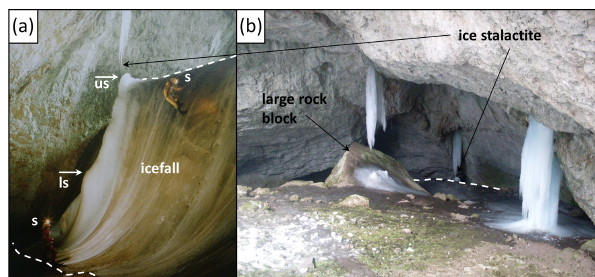
Figure 4. The Silická l’adnica cave contains different types of ice objects. The permanent ice is represented by (a) an icefall (Stankoviˇc and Horváth, 2004) located in the bottom part of the cave. Ice speleothems (b) such as stalactites and stalagmites situated in the upper part of the cave (Ondrej, 2014) are the most dynamic objects with significant seasonal and interannual changes. Approxi- mate size of the icefall can be judged based in the spelunker(s). The icefall is outlined with a white dashed line. The identical location of the ice stalactite in both photographs is marked for better orien- tation. White arrows indicate stalagmites (us – upper stalagmite; ls – lower stalagmite), which tend to accumulate in dry and wet sea- sons or years based on the size of the stalactite marked with a black arrow.